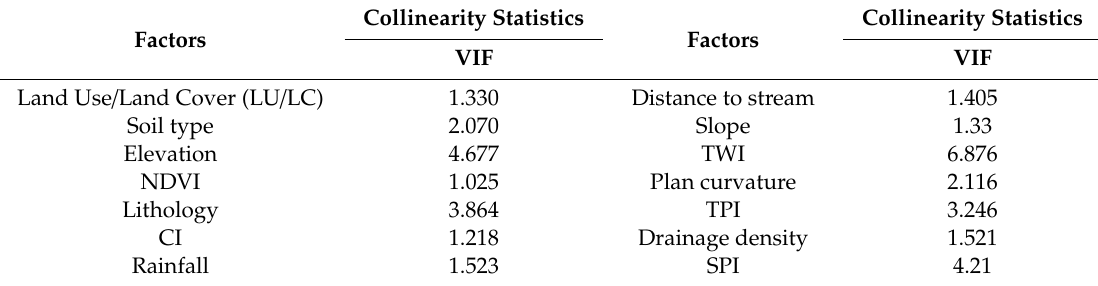
Table 1. Multicollinearity test among flood conditioning